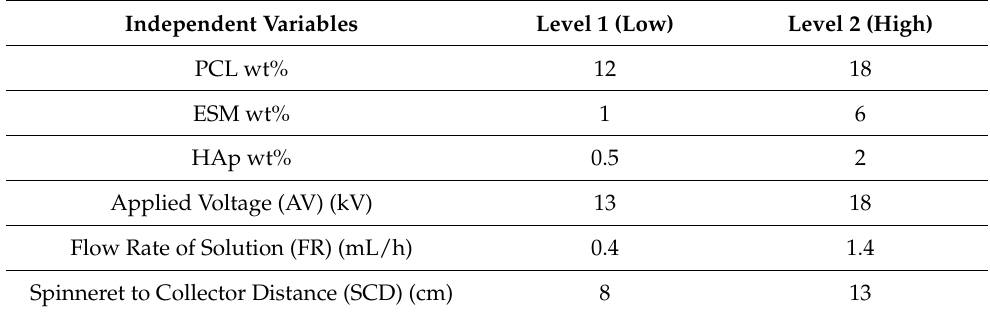
Table 3. The range and levels of the independent variables used for Taguchi orthogonal array design. Independent Variables Level 1 (Low)